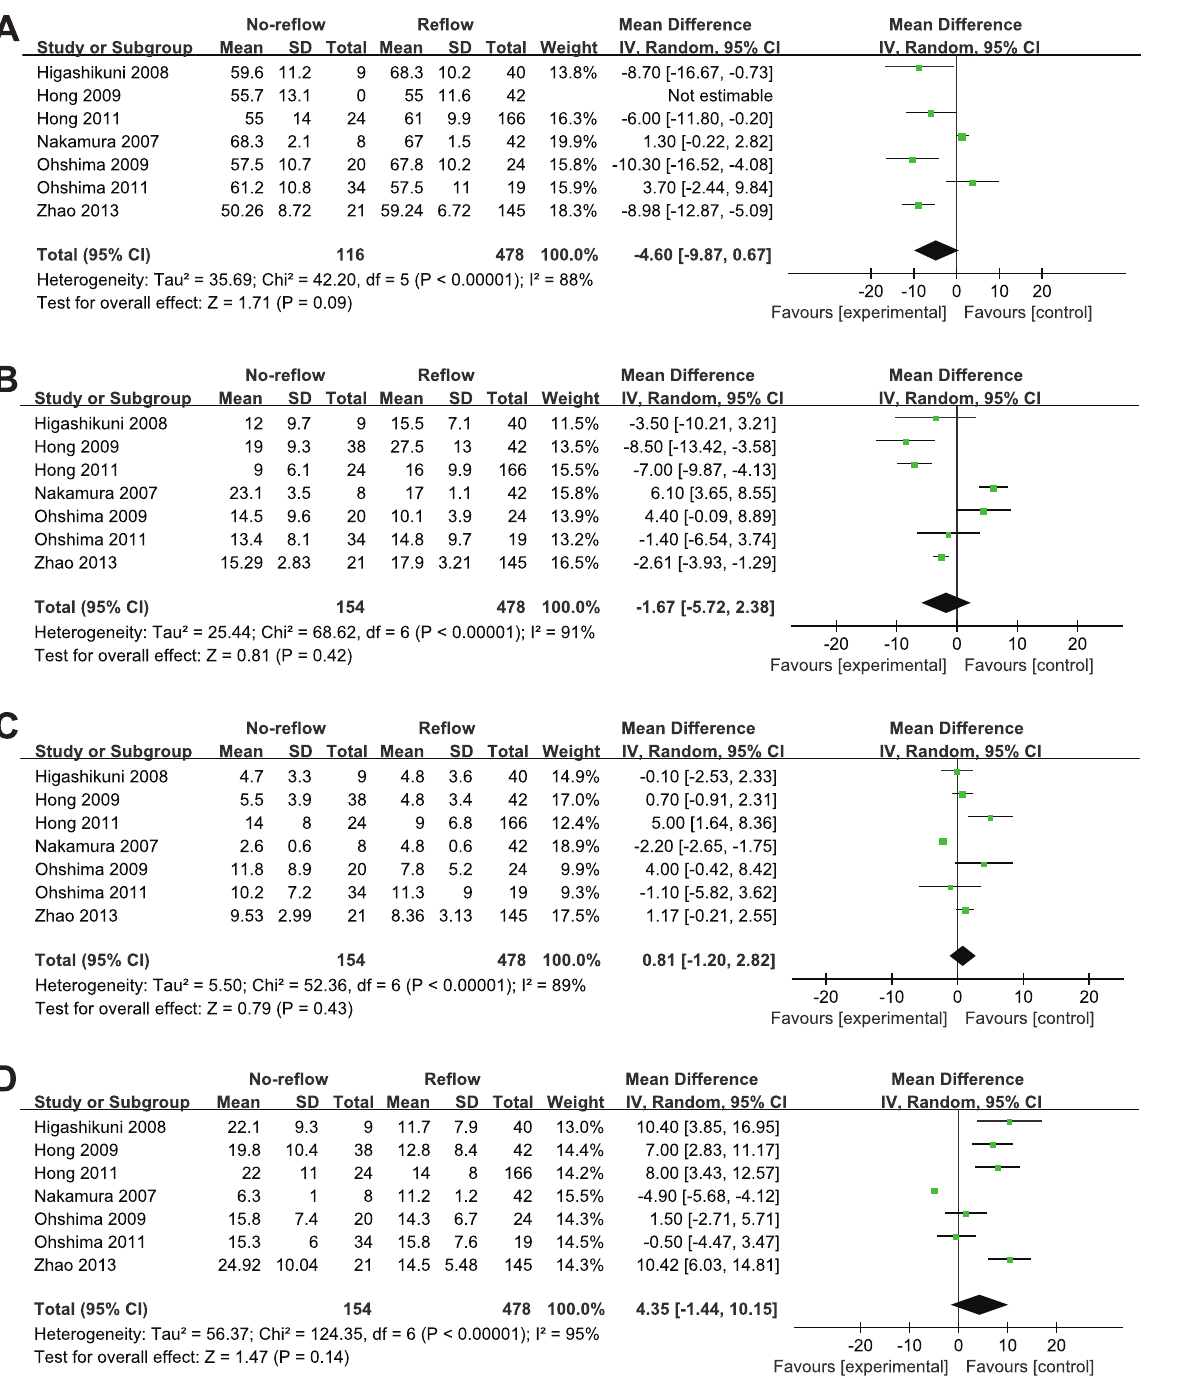
Figure 4. Percentage comparison of four different plaque compositions through the entire culprit lesion between the normal flow group and the distal embolization group. (A) Fibrous percentage comparison; (B) Fibrofatty percentage comparison; (C) Dense calcium percentage comparison; (D) Necrotic core percentage comparison.